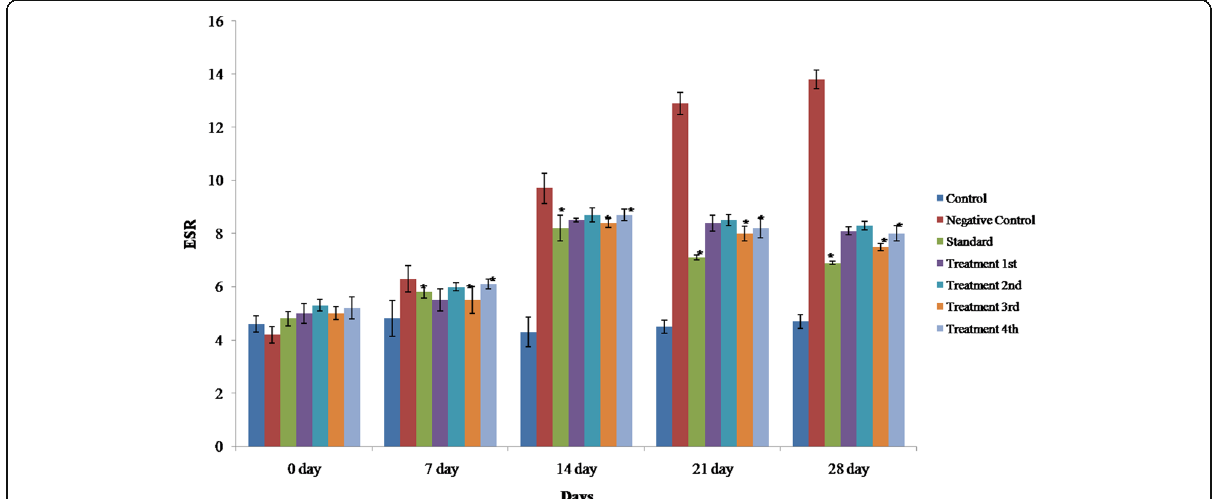
Fig. 8 Effect of PH extracts on ESR. Results are Mean ± S.E.M, n = 6 animals in each group. ANOVA, Dunnett ’ s test *p< 0.05 compared with arthritic control